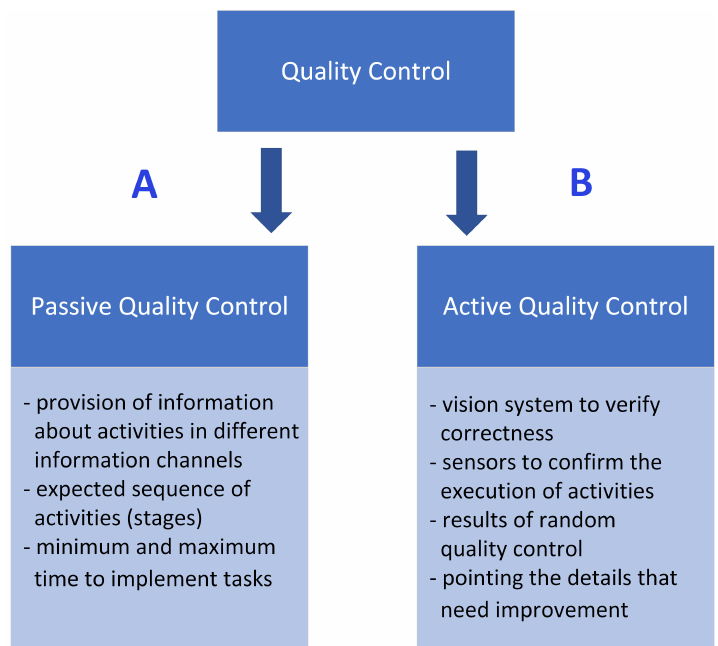
Figure 3. ( A ) Passive and ( B ) Active Quality Control in the exemplary implementation of the HINT system in a wooden joinery production industry